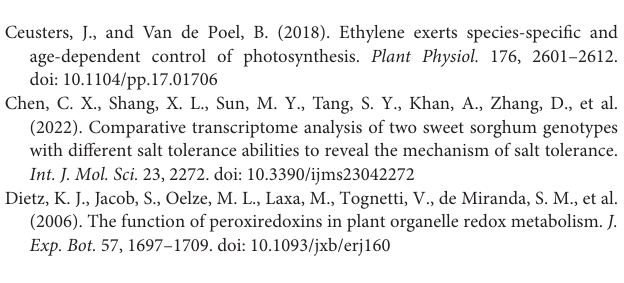
Supplementary Figure 1 | Morphogenesis of C. inerme before salinity stress. (A) Shoot height was measured on day 0 under NaCl stress. (B) Root-to-shoot ratio by dry weight after 14 days under different saline condition. Different letters indicate significant differences among plant groups ( p < 0.05, Mann Whitney test). Mock, no salt control; L, low salt stress; M, medium salt stress; H, high salt stress. Supplementary Table S1 | NaCl concentration for salinity stress. Supplementary Table S2 | Primers used for qRT-PCR. Supplementary Table S3 | Alternatively expressed transcripts under short-term salt exposure. Supplementary Table S4 | Alternatively expressed transcripts under long-term salt